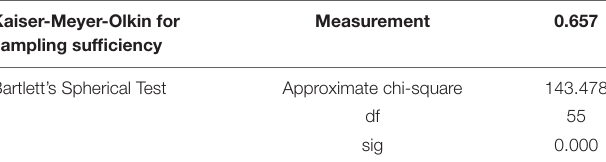
TABLE 4 | KMO and Bartlett’s Spherical